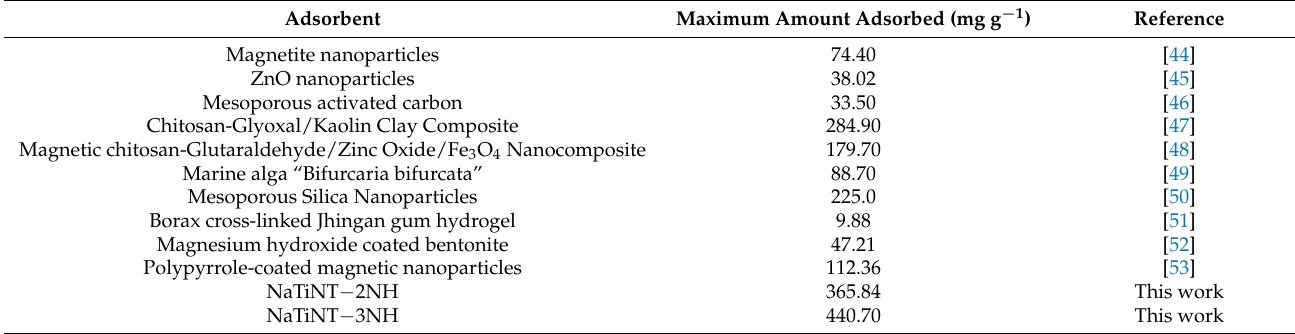
Table 3. Types of adsorbents used to remove acid dye remazol blue R (RB).